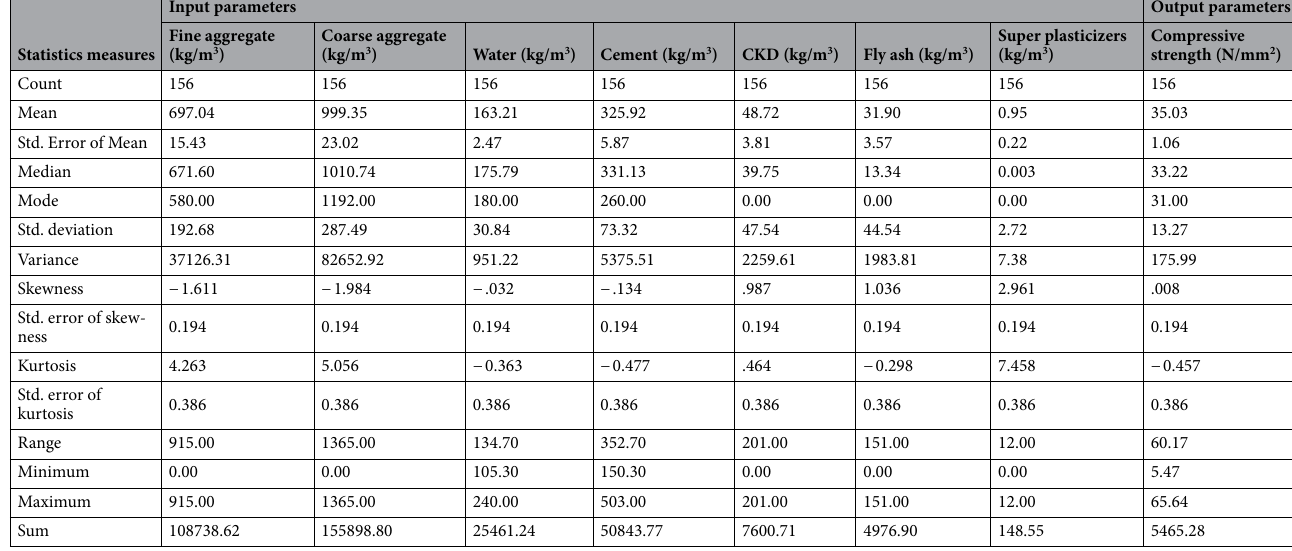
Table 2. Descriptive analysis of database parameters.